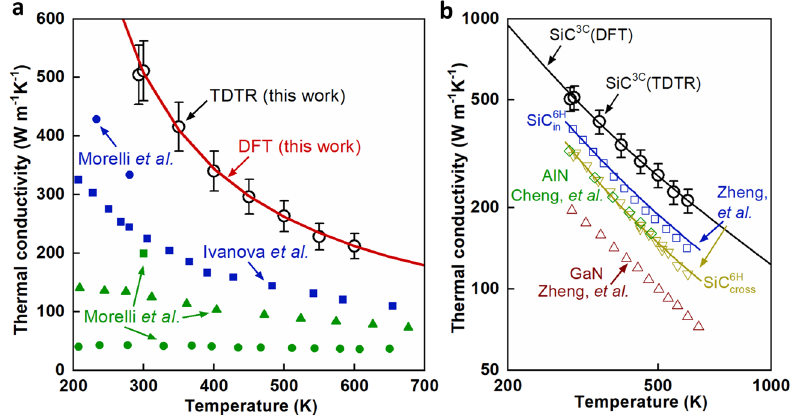
Fig. 3 | Temperature dependent κ of bulk 3C-SiC crystals. a Comparison of the measured κ inthisworkwithpreviousmeasured κ in theliterature 1,50,51 .The κ value (red line) predicted by density functional theory (DFT) in this work is also included 1,52 . The de fi nition of error bars can be found in SI. b Comparison of